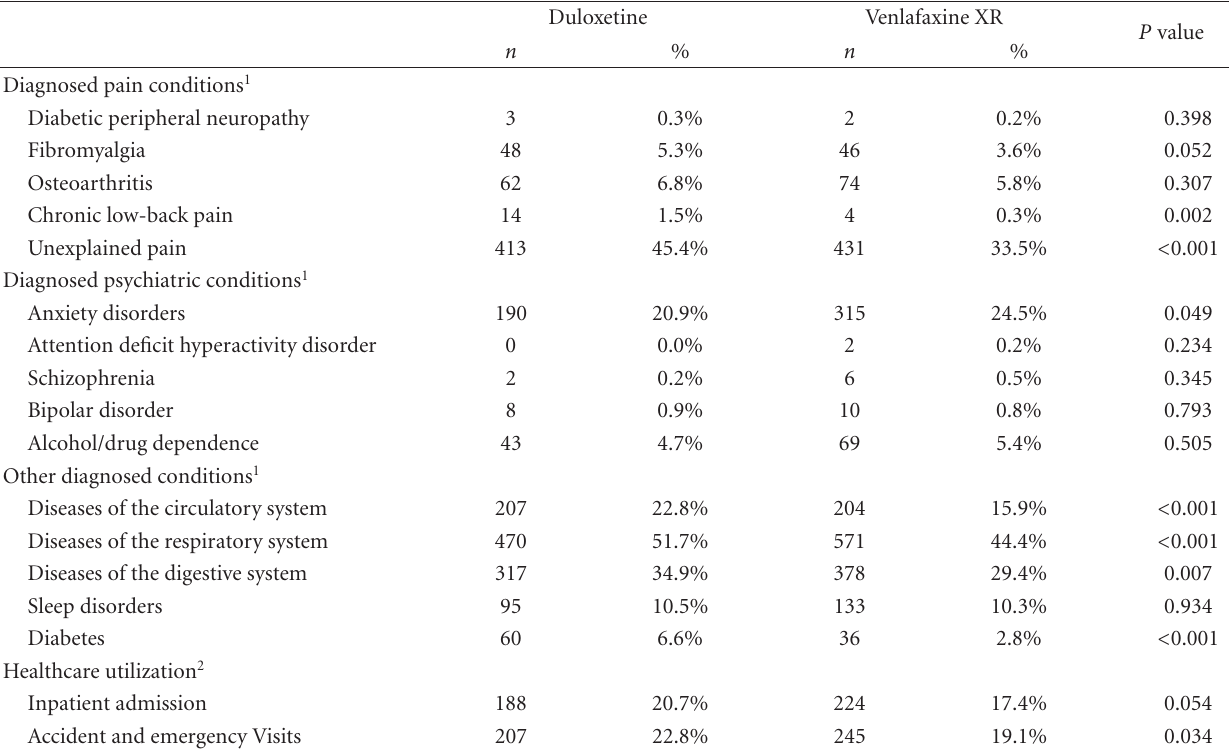
Table 2: Pre-period clinical characteristics of patients initiating duloxetine or venlafaxine